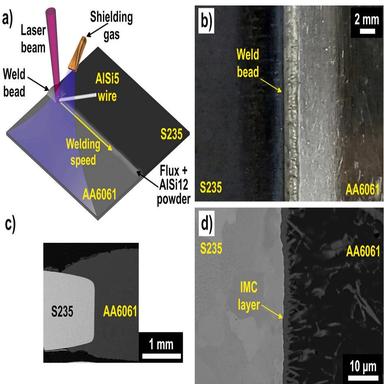
a) Welding-brazing process scheme. b) Visual aspect of a resulting weld bead. c) Weld cross section at low magnification. d) Weld cross section at high magnification showing IMC layer.